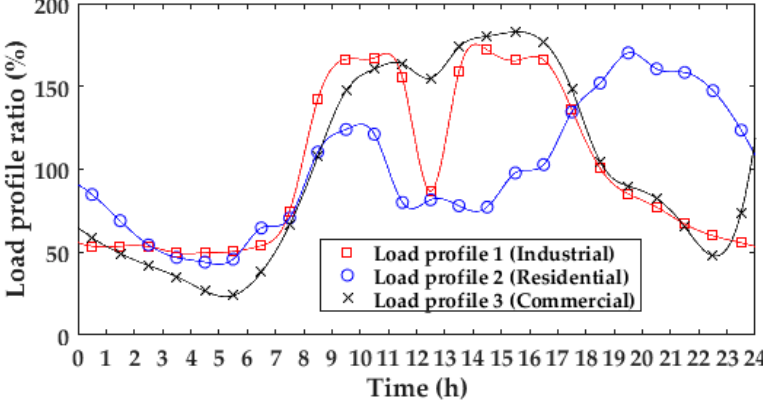
Figure 7. Three different load-demand profiles for industrial, residential, and commercial loads.